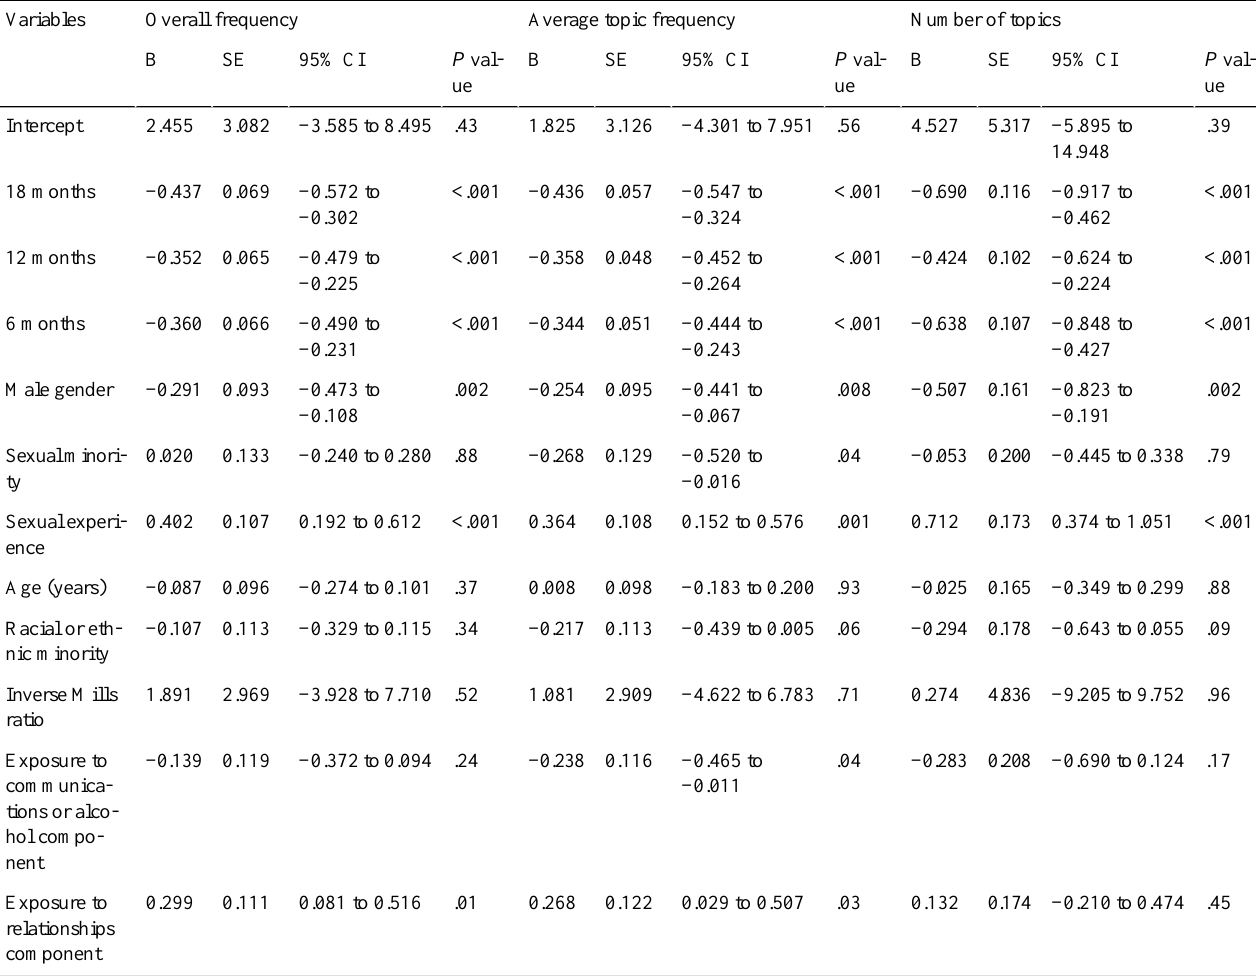
Table 2. Results from generalized estimating equations: main effects of intervention exposure on adolescent report of sexual communication: topics (T0: n=411; T1: n=325; T2: n=311; T3: